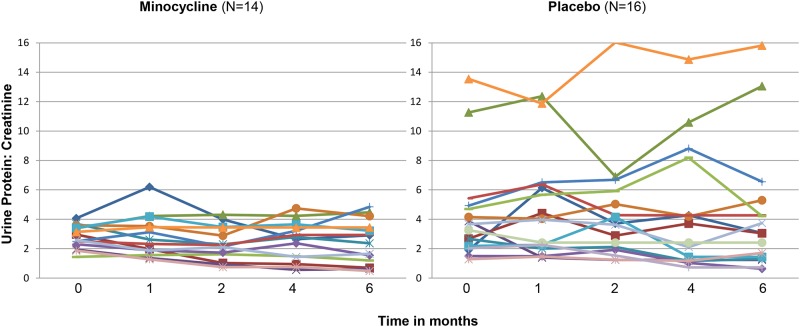
Spaghetti plots of the urine protein: creatinine measurements of each patient in the study over the course of the trial.